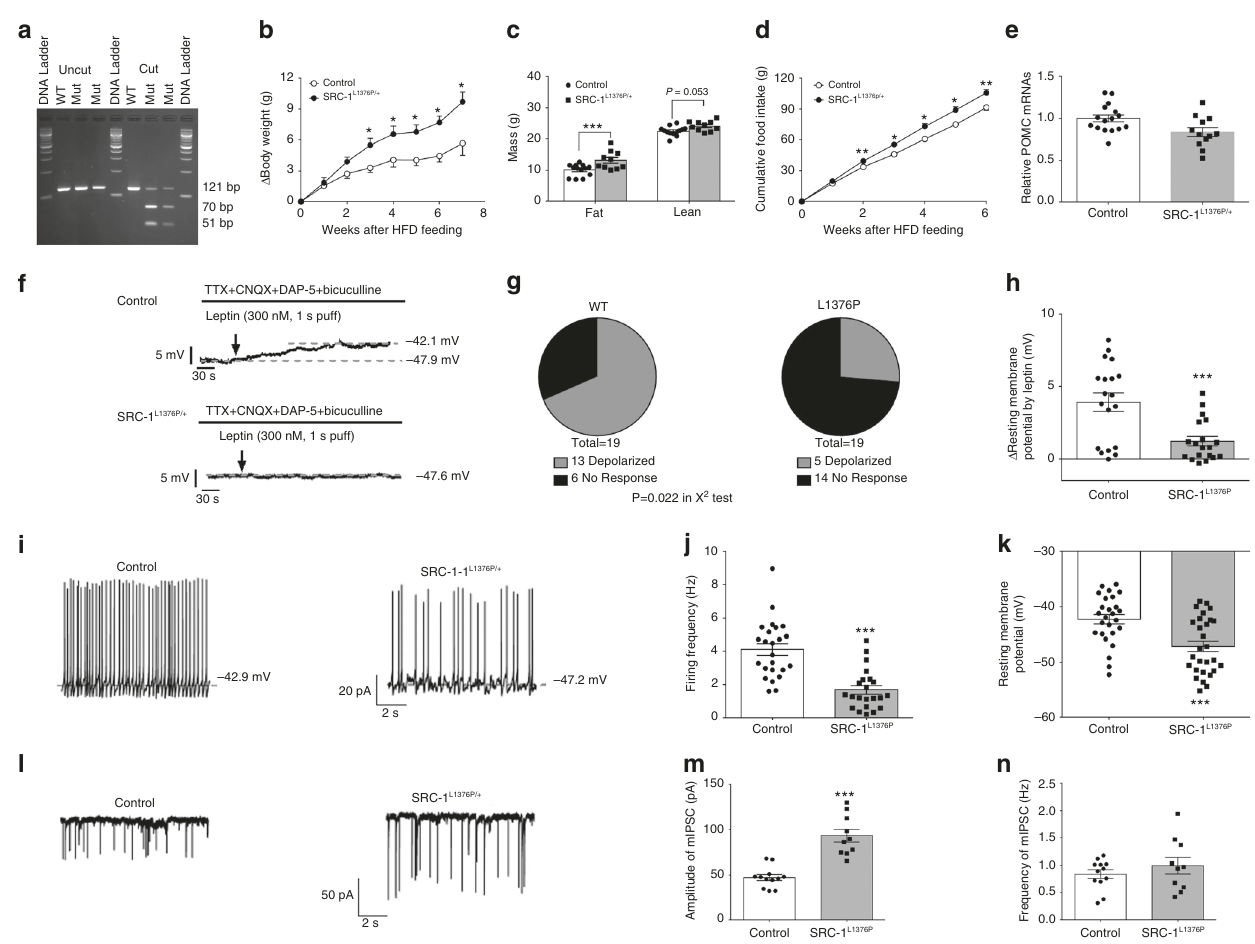
Fig. 4 SRC-1 L1376P/ + mice are obese. Numbers of mice in each group are indicated; data are presented as mean ± SEM and compared using T -tests or two- way ANOVA followed by post hoc Sidak tests (#). a The PCR products (121 bp) around the L1376 were ampli fi ed from genomic DNA extracts of a WT and two SRC-1 L1376P/ + mutant mice and incubated with or without Sau3AI. Control reaction (WT) resulted in a single large fragment (121 bp) and DNAs from the two SRC-1 L1376P/ + mutant mice were cut into two fragments (70 and 51 bp) as expected. b Change in body weight after male control and SRC-1 L1376P/ + mice were fed on a HFD ( n = 5/6); * P < 0.05 (#). c Fat mass and lean mass measured 7 weeks after HFD feeding ( n = 5/6); *** P < 0.001. d Cumulative HFD intake measured ( n = 5/6); * P < 0.05 or ** P < 0.01 (#). e Pomc mRNA levels in hypothalami from 20-week old HFD-fed male control and SRC-1 L1376P/ + mice ( n = 12/16); * P < 0.05. f Representative traces of leptin-induced depolarization, in the presence of TTX, CNQX, DAP-5, and bicuculline, in Pomc neurons from control mice vs. from SRC-1 L1376P/ + mice after 1-week HFD feeding. g Responsive ratio (depolarization is de fi ned as >2 mV elevations in resting membrane potential) ( n = 19); P = 0.022 in χ 2 tests. h Quanti fi cation of leptin-induced depolarization in two groups ( n = 19); *** P < 0.001. i Representative traces of action potentials in untreated Pomc neurons from control mice vs. from SRC-1 L1376P/ + mice. j , k Quanti fi cation of fi ring frequency ( j ) and resting membrane potential ( k ) in two groups ( n = 22 – 28); *** P < 0.001. l Representative traces of mIPSC in untreated Pomc neurons from control mice vs. from SRC-1 L1376P/ + mice. m , n Quanti fi cation of amplitude ( m ) and frequency ( n ) of mIPSC in two groups ( n = 10/12); *** P < 0.001. Source data are provided as Source Data Fig.